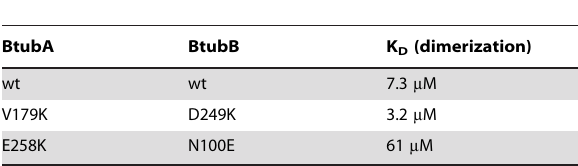
Table 2. Sedimentation